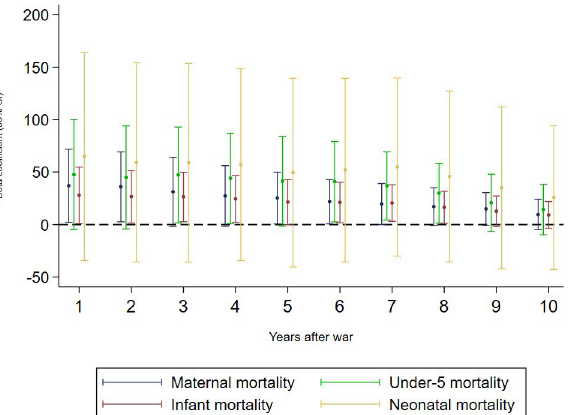
Fig 1. The association between war and maternal and child mortality with up to 10-year lags. Each line represents the output from a fixed effects panel regression model adjusted for 10 covariates and year fixed effects, showing the war coefficient only. Under-5 and infant mortality are scaled up by a factor of 10, and neonatal mortality is scaled up by a factor of 100, to fit the